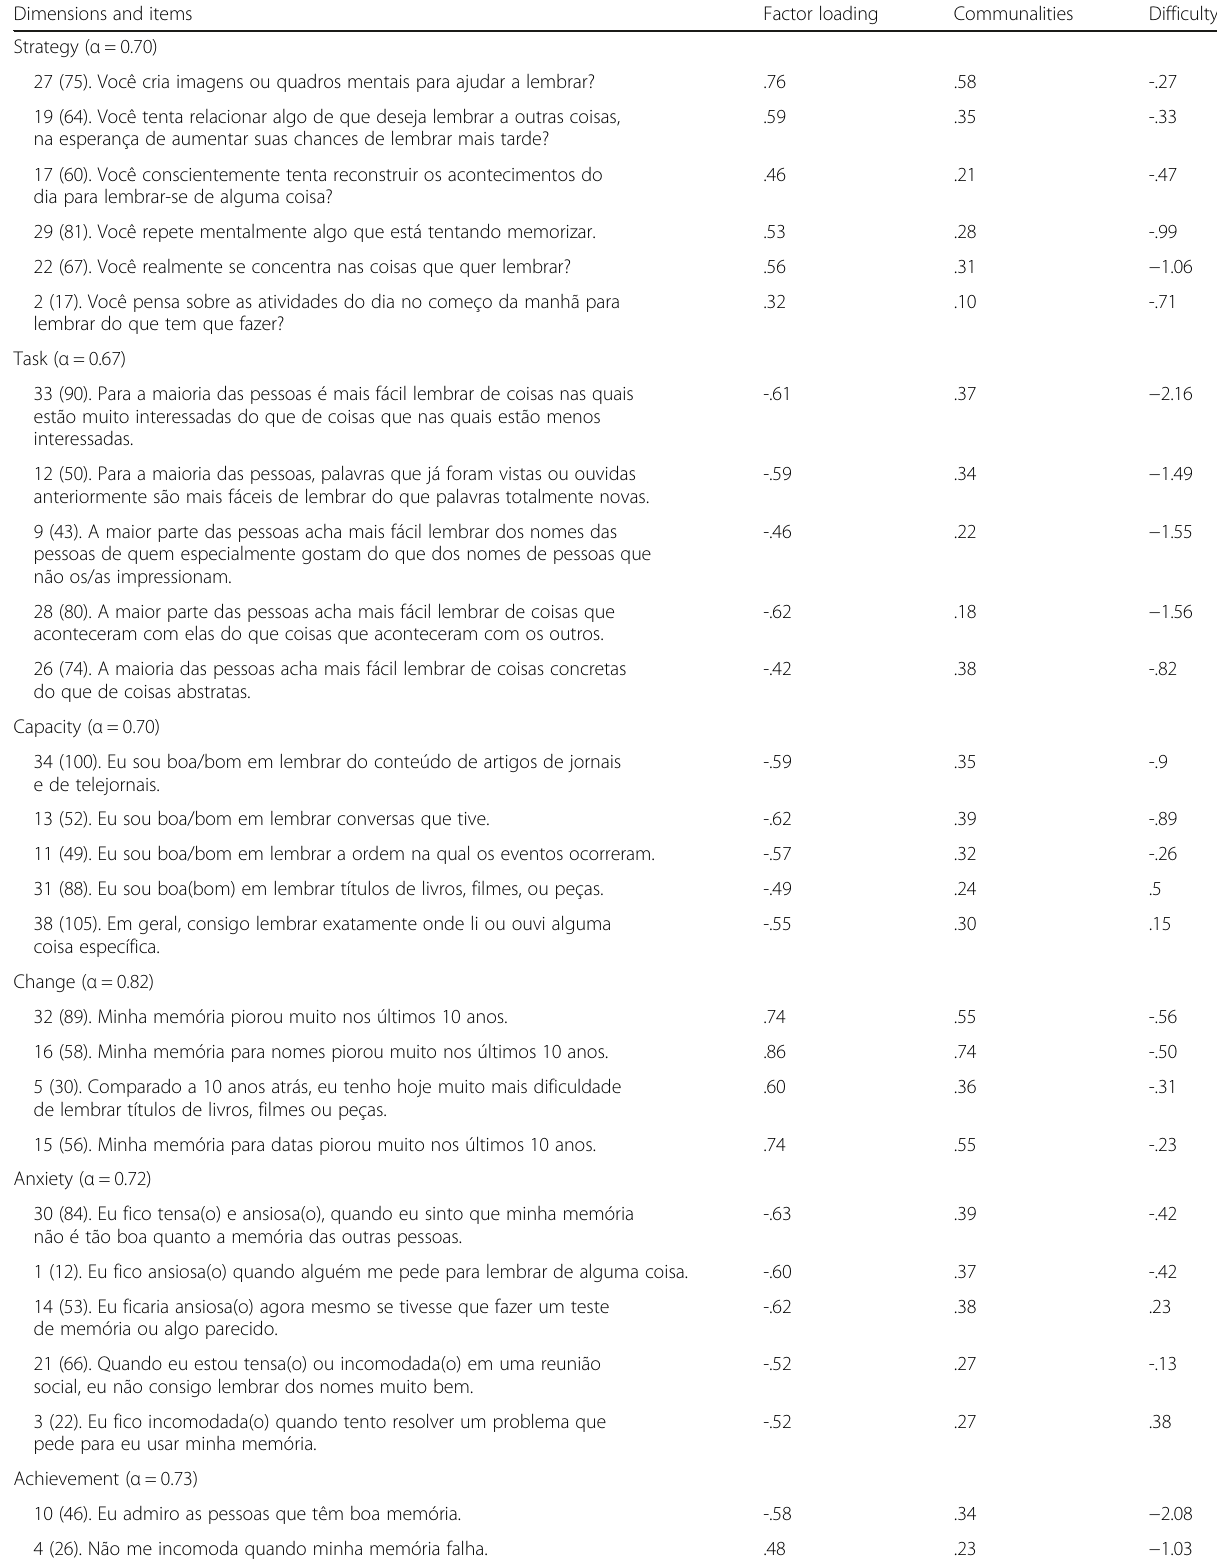
Table 2 Items factor loadings, communalities and difficulty for each subscale of the MIAr Dimensions and